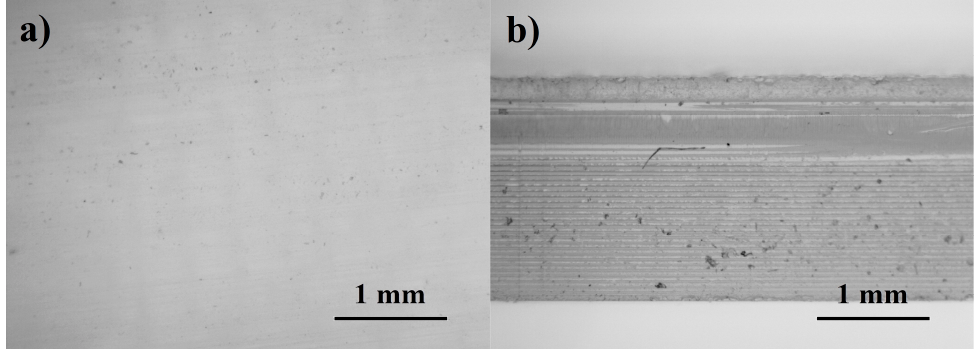
Figure 3. Images of the surface ( a ) and side ( b ) of the resin sample.